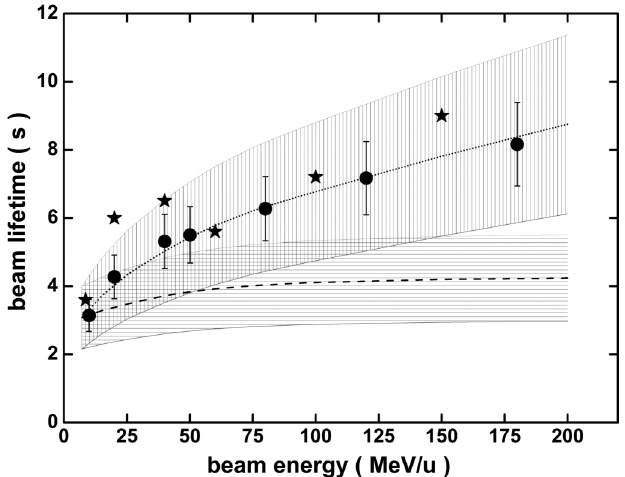
FIG. 3. U 28 þ beam lifetimes in the SIS18 synchrotron plotted versus the beam energy. The experimental data obtained in this work are marked by full circles, while stars denote results from a previous measurement [25]. The STRAHLSIM results together with an error margin of 30% (shaded area) are illustrated by a dotted line ( LOSS-R code cross sections) and a dashed line ( n CTMC cross sections),